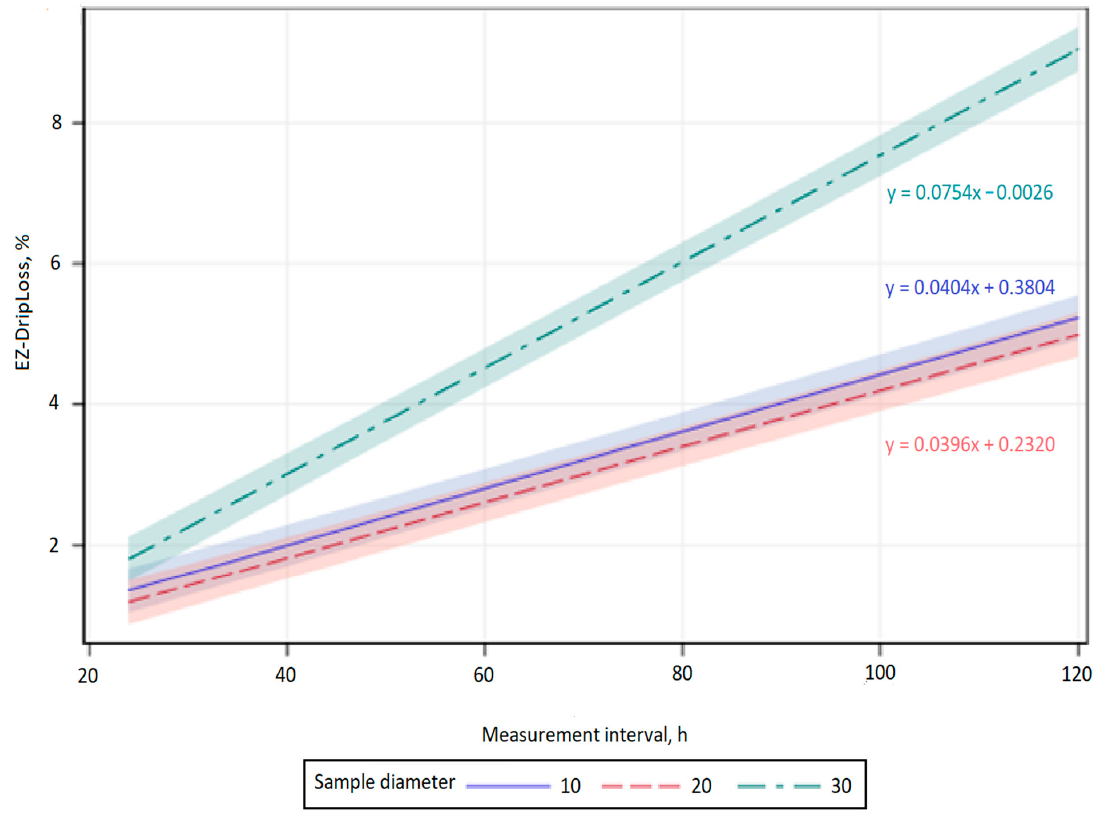
Figure 2. Predictions and confidence bands for a linear regression of measurement interval for EZ-DripLoss of chicken breast meat in relation to horizontal fiber direction and core diameter (10, 20, and 30 mm).